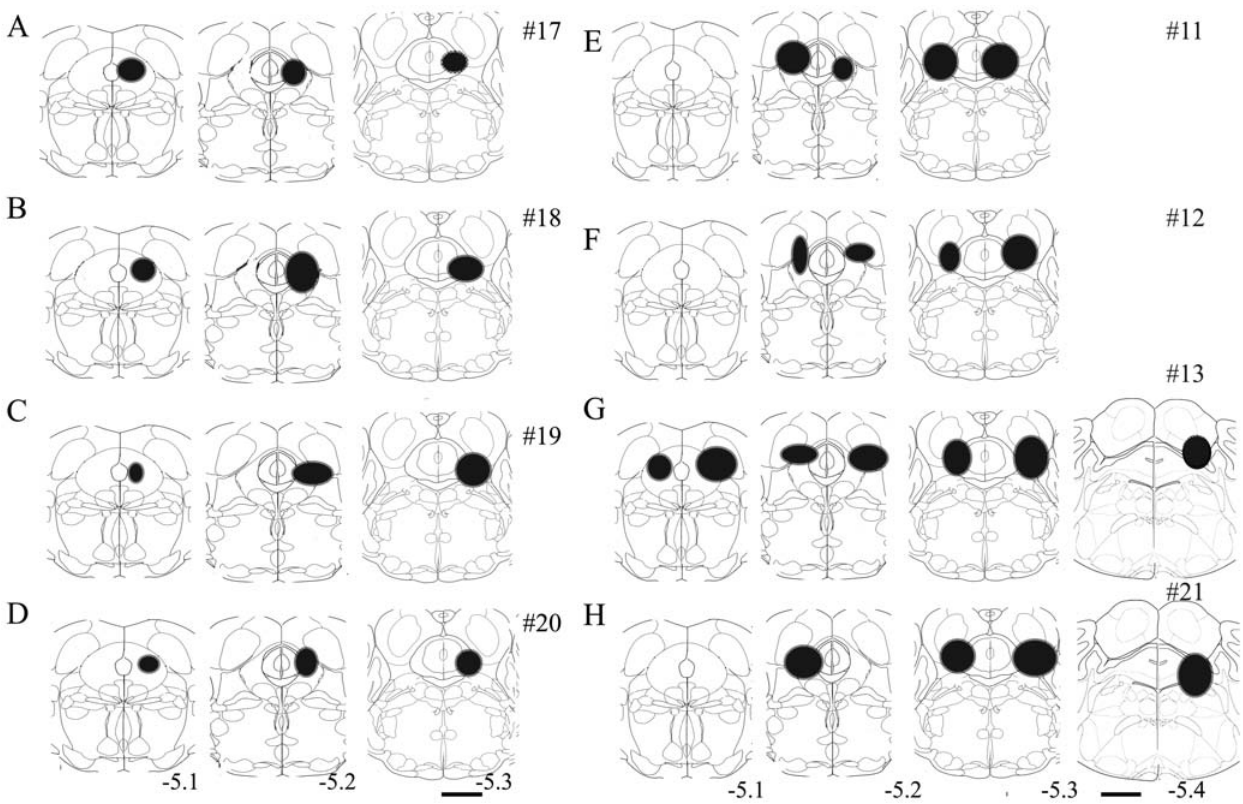
Figure 14. Location and spread of the retrograde tracer, cholera toxin subunit b (CTb) in the vlPAG area, as observed by the immunohistochemistry for the CTb in the eight mice (A-H). In mice # 17–19 the CTb was injected unilaterally (right side), whereas in mice 11, 12, 13 and 21 it was injected bilaterally into the vlPAG area. In one mouse ( # 21) the CTb spread caudally into the locus coeruleus as shown in H. The numbers of retrogradelylabeled neurons in specific brain regions in each mouse is summarized in Table 2. Scale=1 mm.